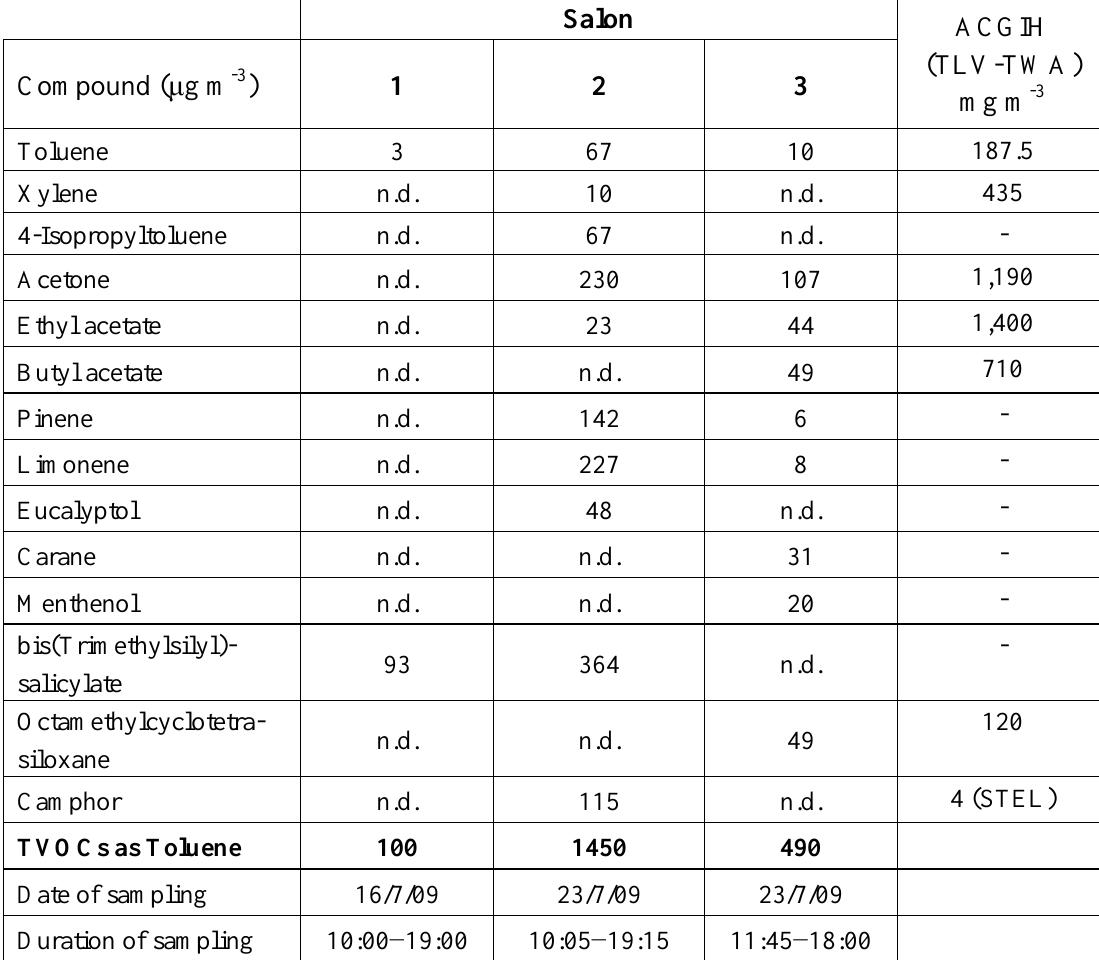
Table 2. Main VOCs found in three salons (8h-TWA levels in μg m -3 ) and the corresponding occupational exposure